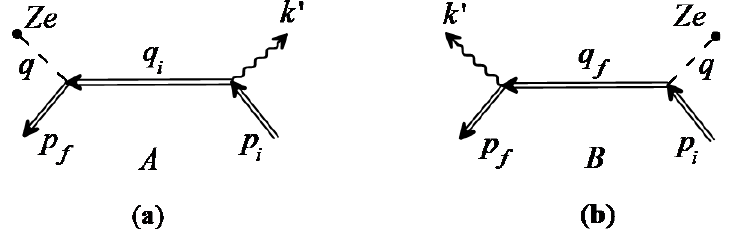
Figure 1. The Feynman diagrams of the resonant bremsstrahlung of ultrarelativistic electrons on a nucleus with hard gamma-quanta radiation in the presence of a pulsed field of the X-ray pulsar. ( a ) Diagram A corresponds to the channel A. ( b ) Diagram B corresponds to the channel B. The double incoming and outgoing lines correspond to the Wolkow functions of an electron in the initial and final states, the inner double line corresponds to the Green function of an electron within a pulsed electromagnetic field (4). The waved lines correlate to the 4-momenta of the hard gamma-quanta and the dashed lines illustrate the “pseudo-photon” of a nucleus